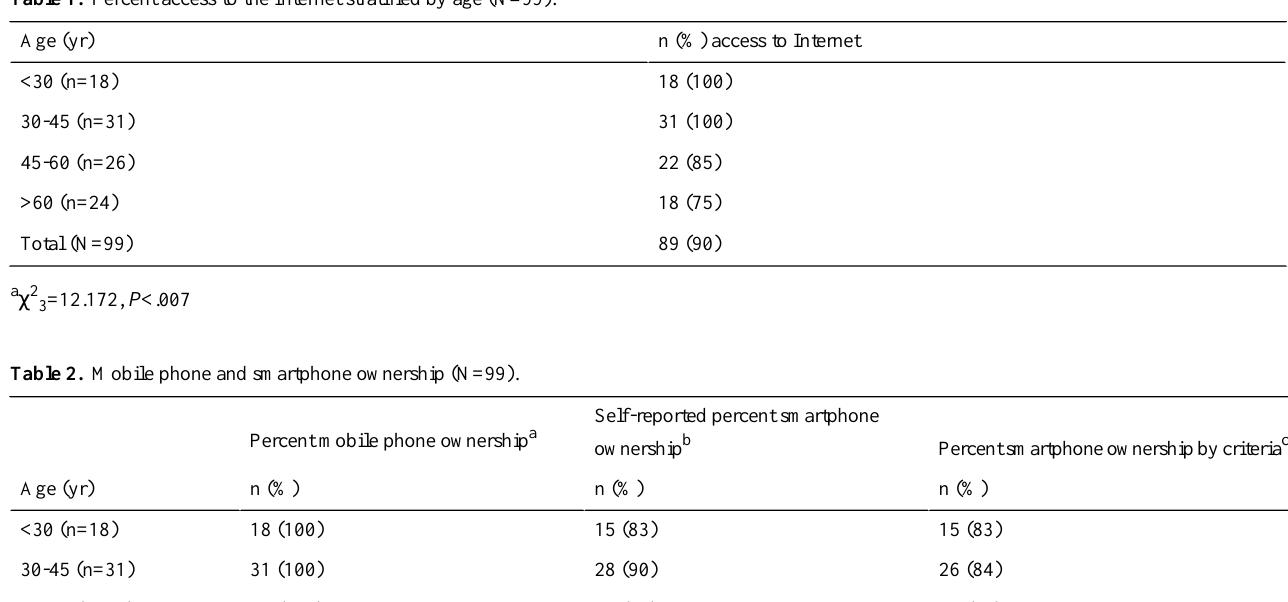
Table 1. Percent access to the Internet stratified by age (N=99). a